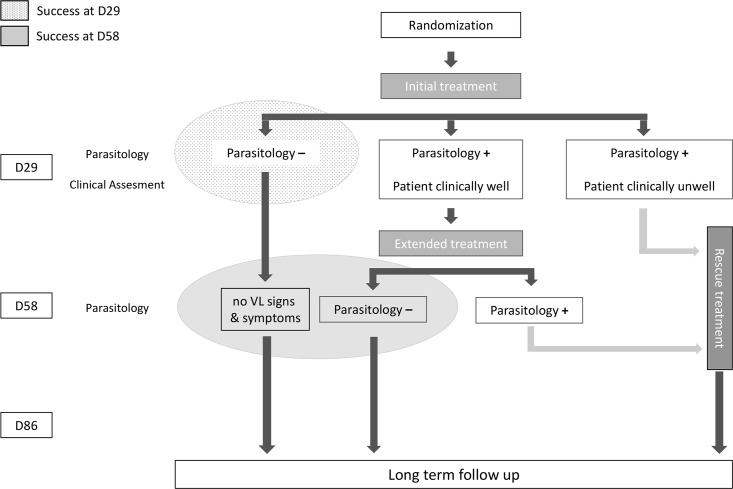
Treatment strategy.